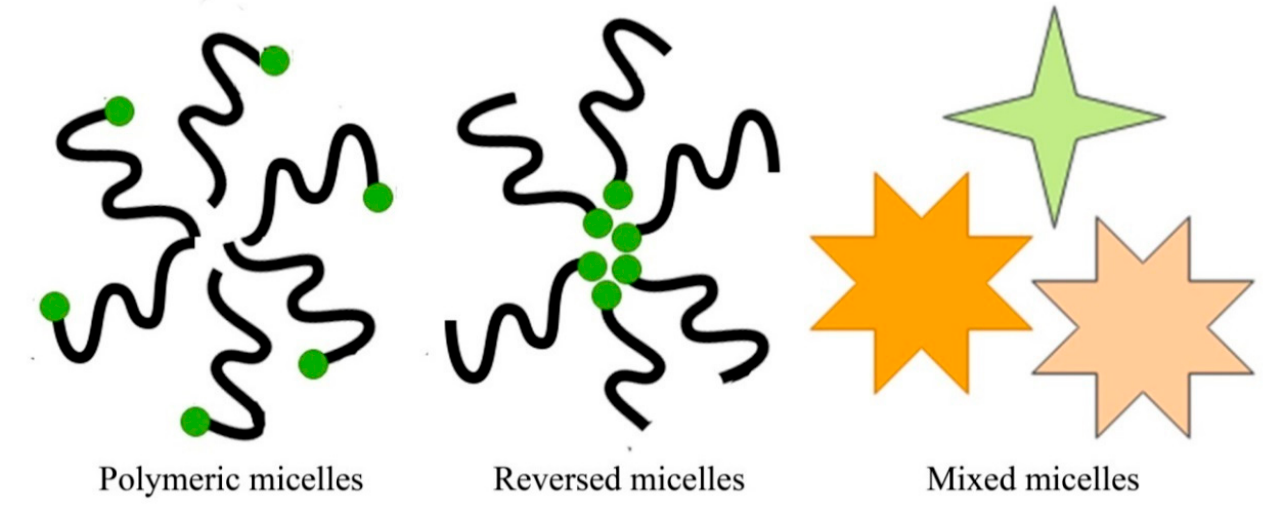
Figure 6. Basic structures of micelle drug delivery systems.